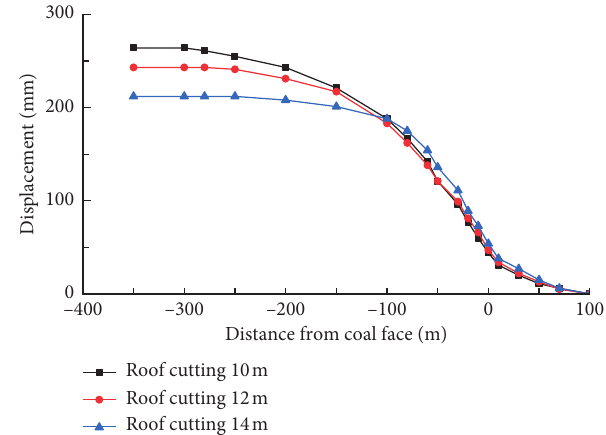
Figure 19: Deformation of two sides of the